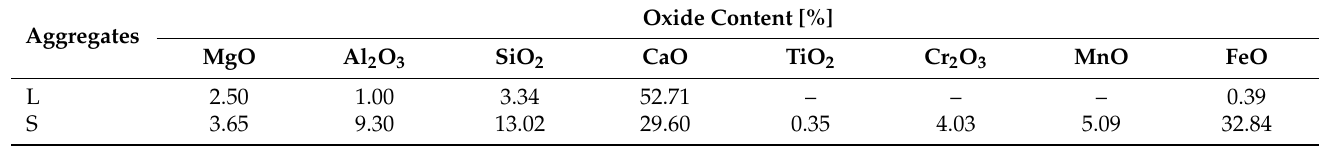
Table 3. Morphological composition of the selected